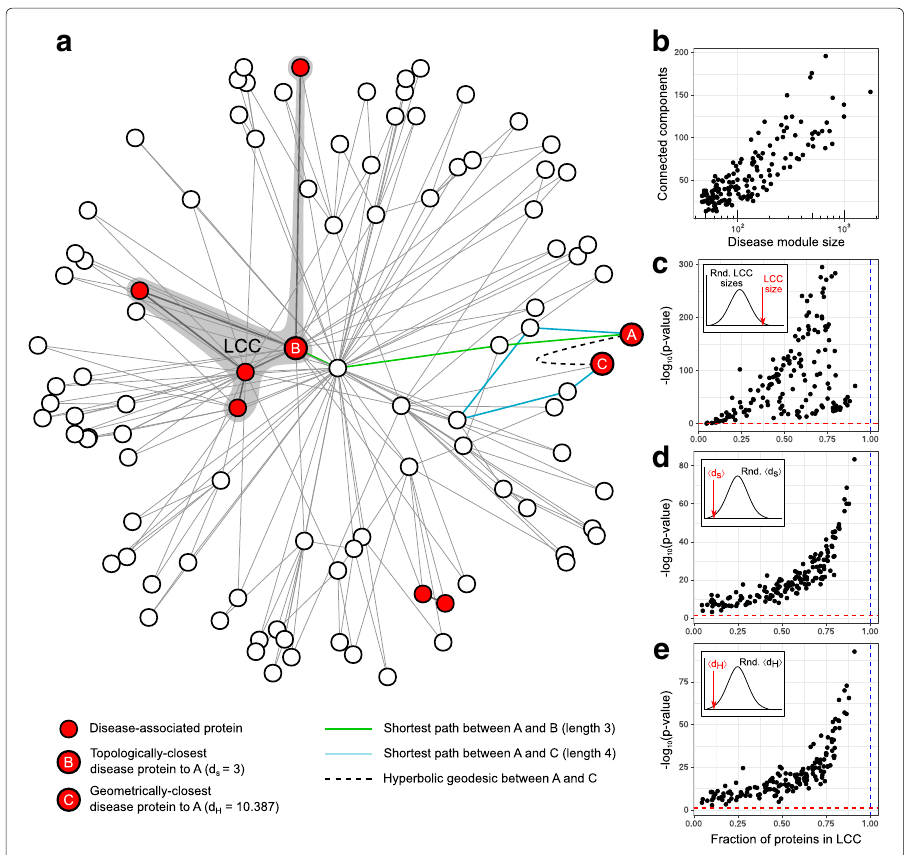
Fig. 1 Topology and geometry of disease modules. a A toy protein network embedded in H 2 and the gene products associated with a disease highlighted in red. The resulting DM is fragmented in 4 components and thelargestone(LCC)hassize5.Thetopologically-closestproteintoAisB( d s = 3)anditsgeometrically-closest protein is C ( d H = 10.387), although it is 4 hops away from A. b The 157 studied DMs are split into several connected components in the hPIN. c The LCC size of each DM was compared with a random distribution of LCC sizes via a z-test. d The average of the shortest paths from each disease protein to its topologically-closest other DM member ( (cid:4) d s (cid:5) ) was compared with random expectation via a z-test. e The average of the hyperbolic distances from each disease protein to its geometrically-closest other DM member ( (cid:4) d H (cid:5) ) was compared with random expectation via a z-test. The red lines correspond to the significance level α = 0.05 and the blue ones to the situation in which all proteins associated with a disease form a single connected